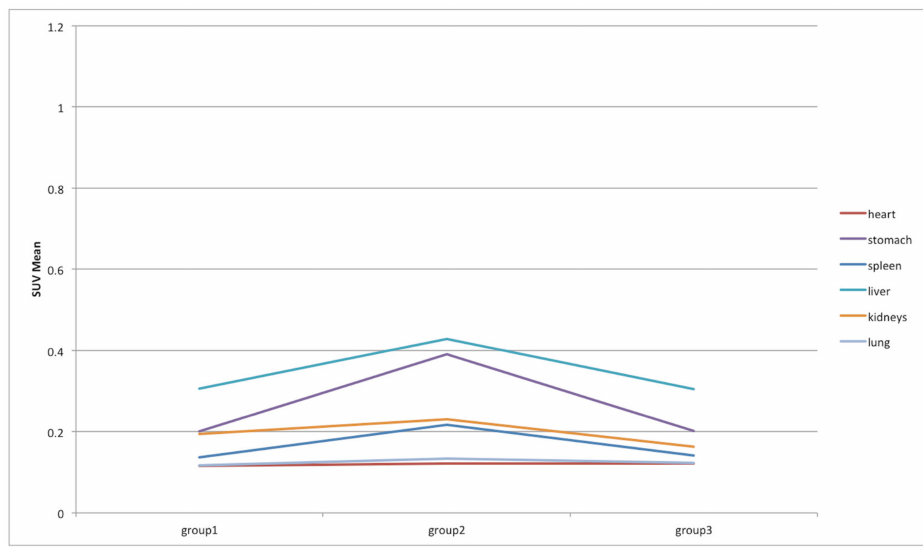
Figure 11. SUV mean variations among groups in heart, stomach, spleen, liver, kidneys, and lung districts.